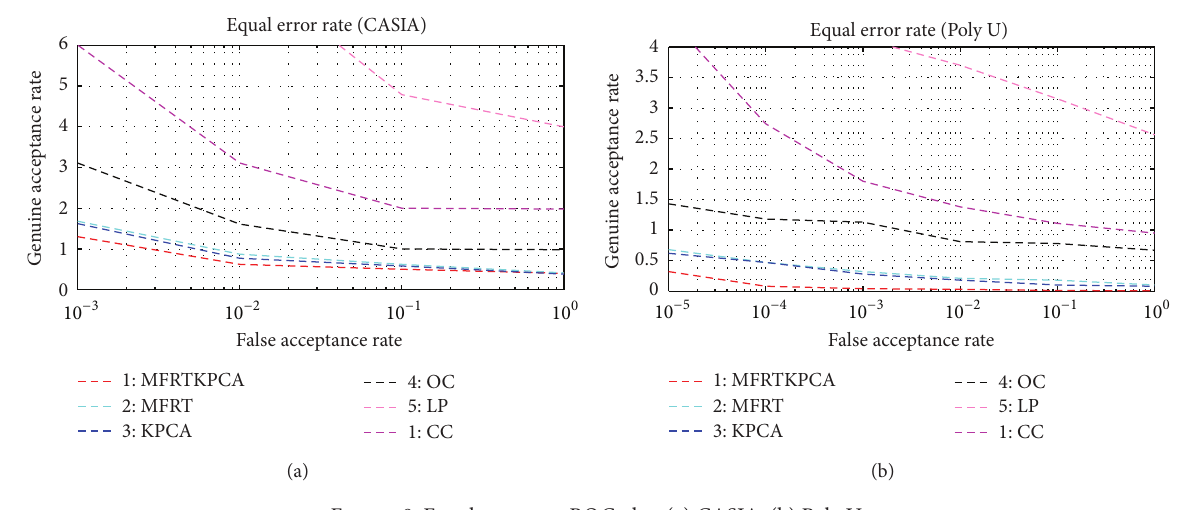
Figure 8: Equal error rate ROC plot: (a) CASIA, (b) Poly